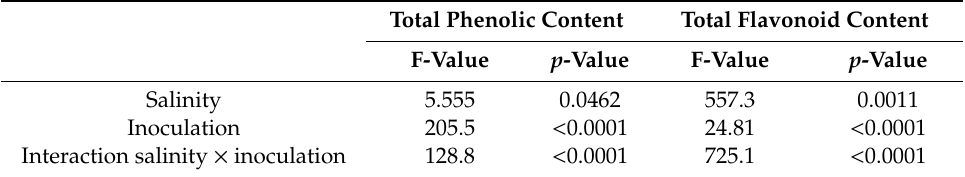
Table 5. Results of two-way ANOVA performed to assess the e ff ect of salinity and inoculation on the total content of phenolic acids and flavonoids in lettuce